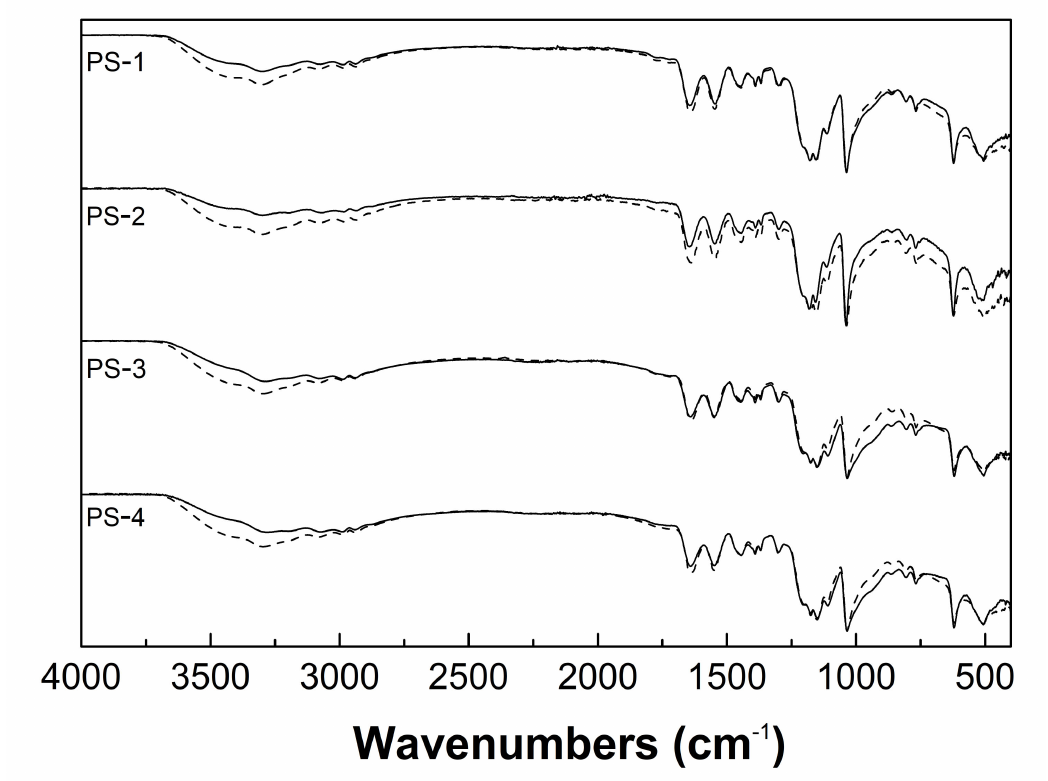
Figure 6. Fourier-transformed infrared spectroscopy with attenuated total reflectance (ATR–FTIR): spectra of homopolymers PS1–PS4 assessed directly after lyophilization (solid line) and after a fourteen-day exposure to the ambient atmosphere (dashed